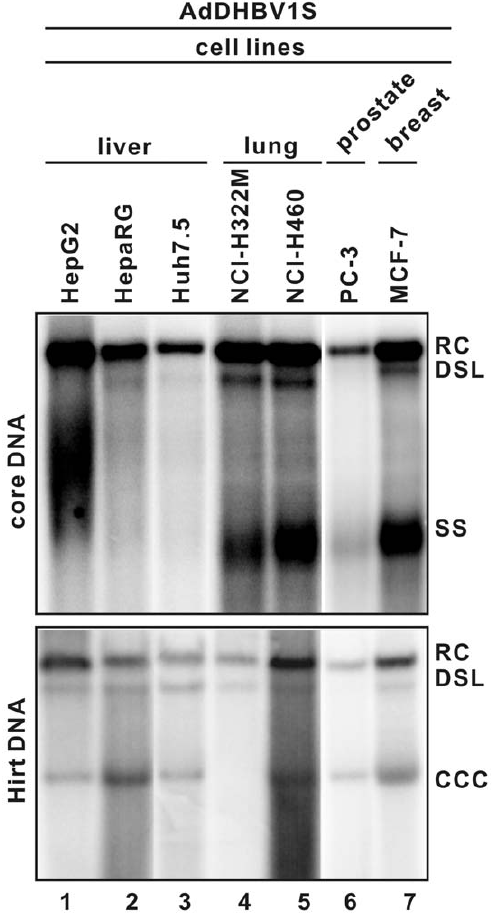
Figure 5. DHBV DNA replication and cccDNA formation in a panel of human cell lines infected by AdDHBV1S. The indicated cell lines were seeded onto 6-well plate and infected with AdDHBV1S at a MOI of 10. Five days post infection, DHBV core-associated (A) and Hirt DNA (B) were extracted and analyzed by Southern blot hybridization. Each lane represents the amount of viral DNA extracted from one half of cells in a well of 6-well plate.